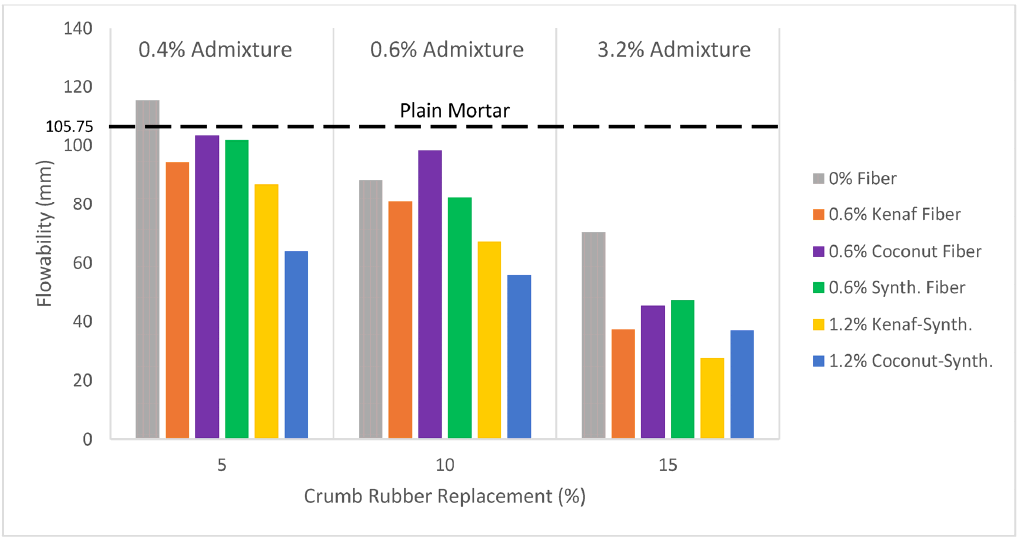
Figure 4. Flowability of CRM containing 0–1.2%